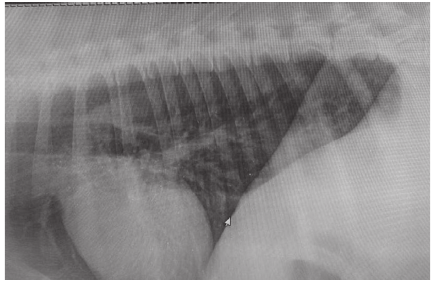
Figure 5: Lateral radiograph of a female Labrador showed com- plete regression of lung metastasis after the third dose of cyclo- phosphamide